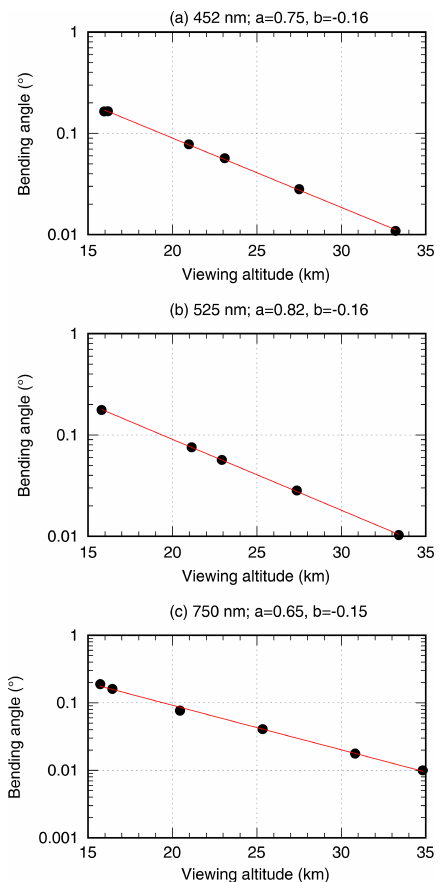
Figure B2. Fit of bending angle parameters a and b for different